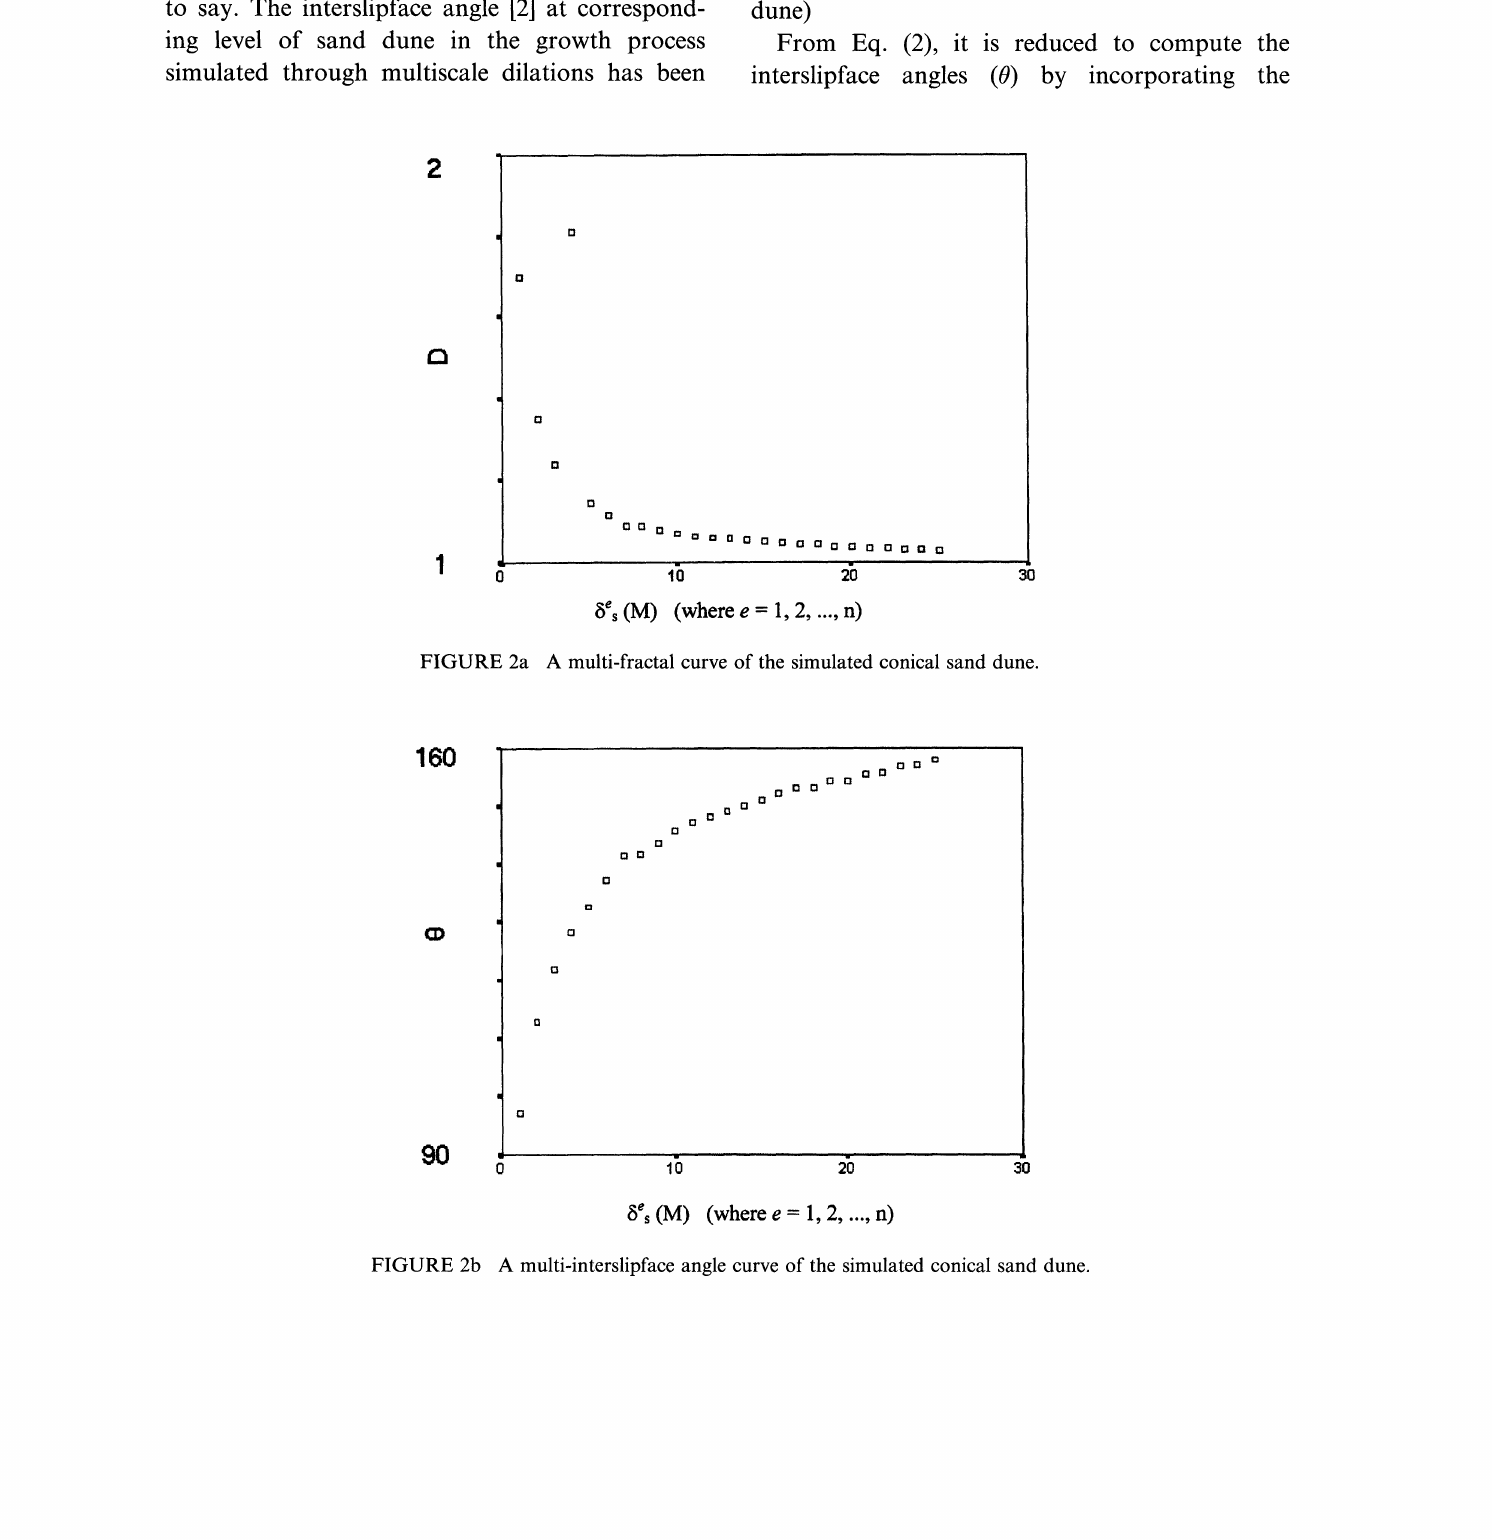
FIGURE 2b A multi-interslipface angle curve of the simulated conical sand